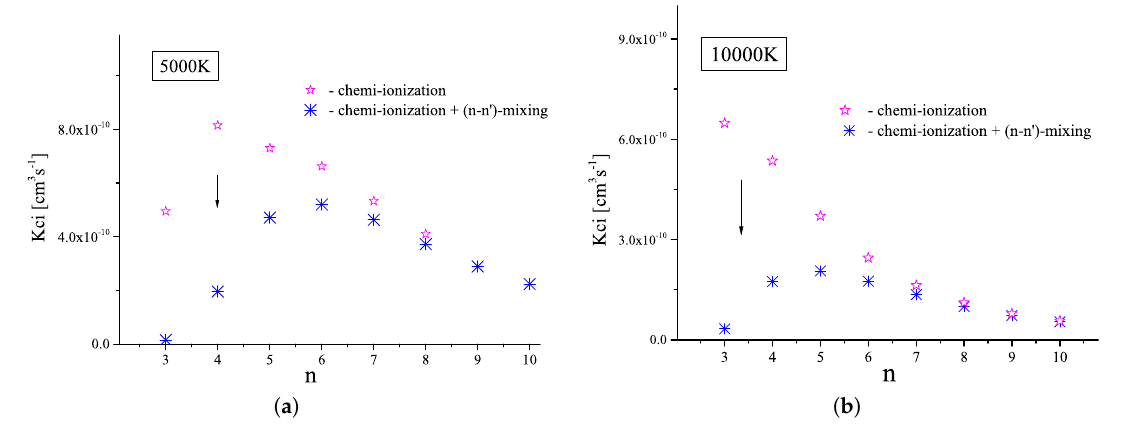
Figure 9. ( a ) comparison of the calculated values of rate coefficients of the chemi-ionization processes (1a,b) with and without inclusion of (n-n’)-mixing process, case A = H; ( b ) same as in ( a ) but for case A = He.